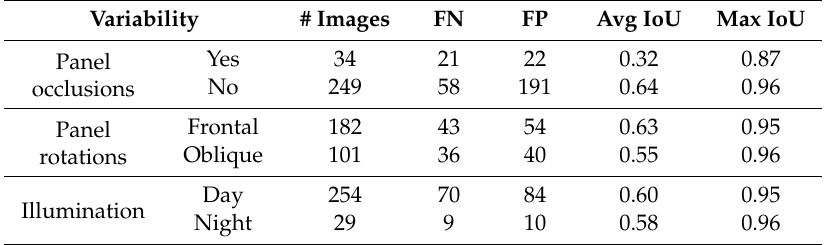
Table 8. Specific results for YOLOv3 with respect to occlusions, rotations and illumination.